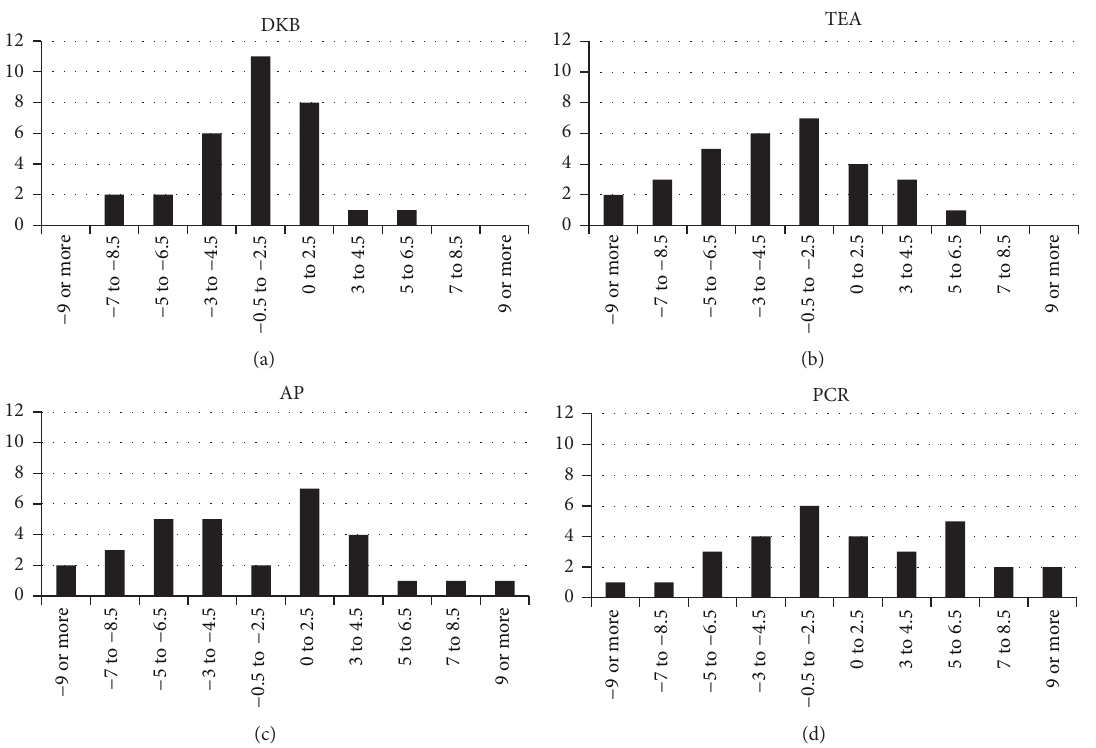
Figure 7: Histograms of rotational alignment (in degrees) based on DKB and alternative